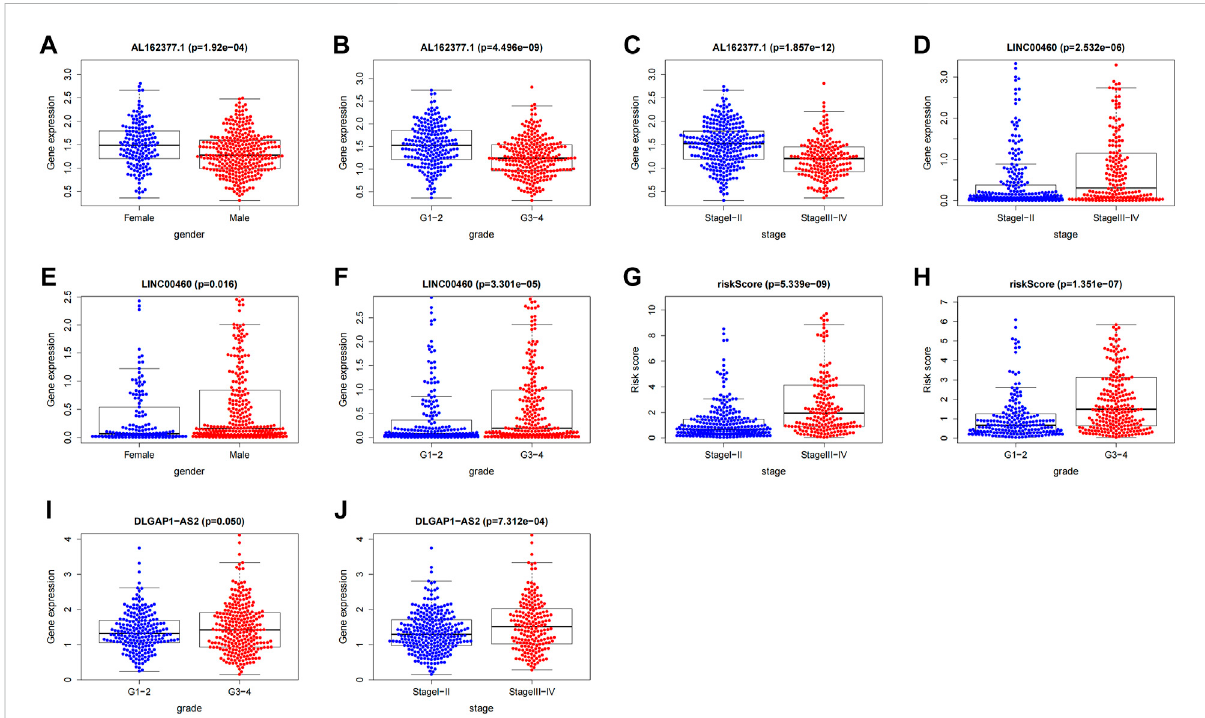
FIGURE 13 CorrelationanalysisbetweenCTZFLsandclinicalcharacteristics. (A – C) CorrelationbetweenAL162377.1expressionlevelandgender,gradeand stage. (D – F) Relationship between LINC00460 expression level and gender, stage and grade. (G – H) Relationship between risk score and tumor grade and stage. (I – J) Relationship between DLGAP1-AS2 expression level and tumor grade and stage. CTZFLs, CCCH-type zinc fi nger protein- associated